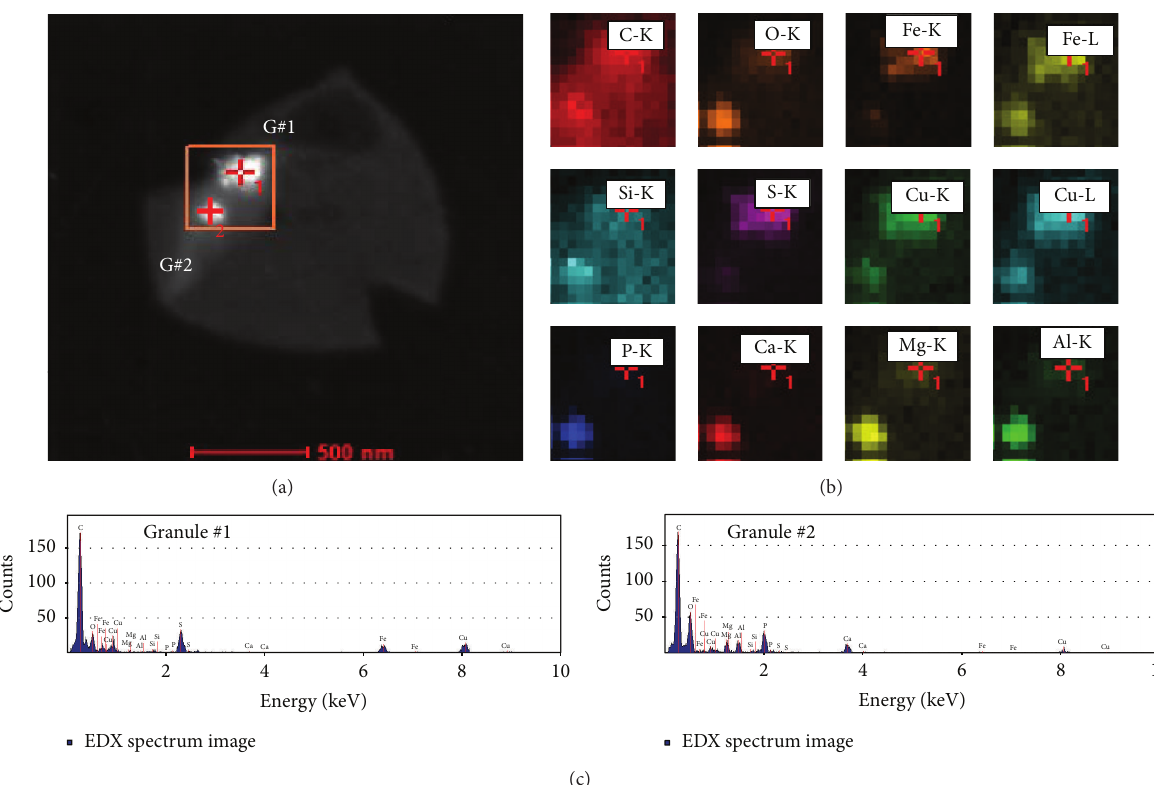
Figure 6: Combined EDX analysis of two granules in a single A. fulgidus cell. (a) STEM image of the analyzed cell; the area scanned by the probe is shown as an orange box. The two granules are labeled as G#1 and G#2. (b) The EDX area scans for each element found in the region specified in (a), which contains both G#1 and G#2. Each element is plotted in a different color. (c) The individual EDX point spectra from the locations specified in (a) by crosses with the numbers 1 and 2. The first spectrum is from G#1 and the second one is from G#2.